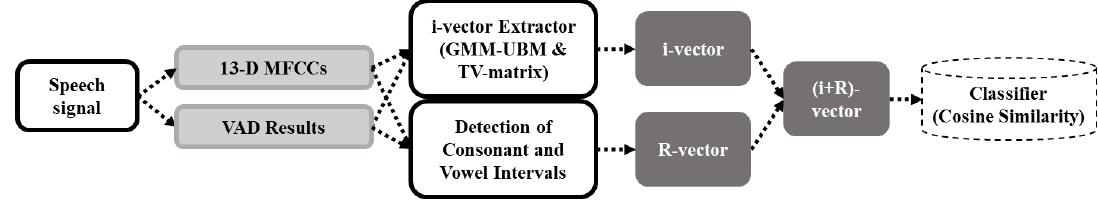
Figure 4. Procedure of Language IDentification (LID) based on a combination of i-vector and R-vector.